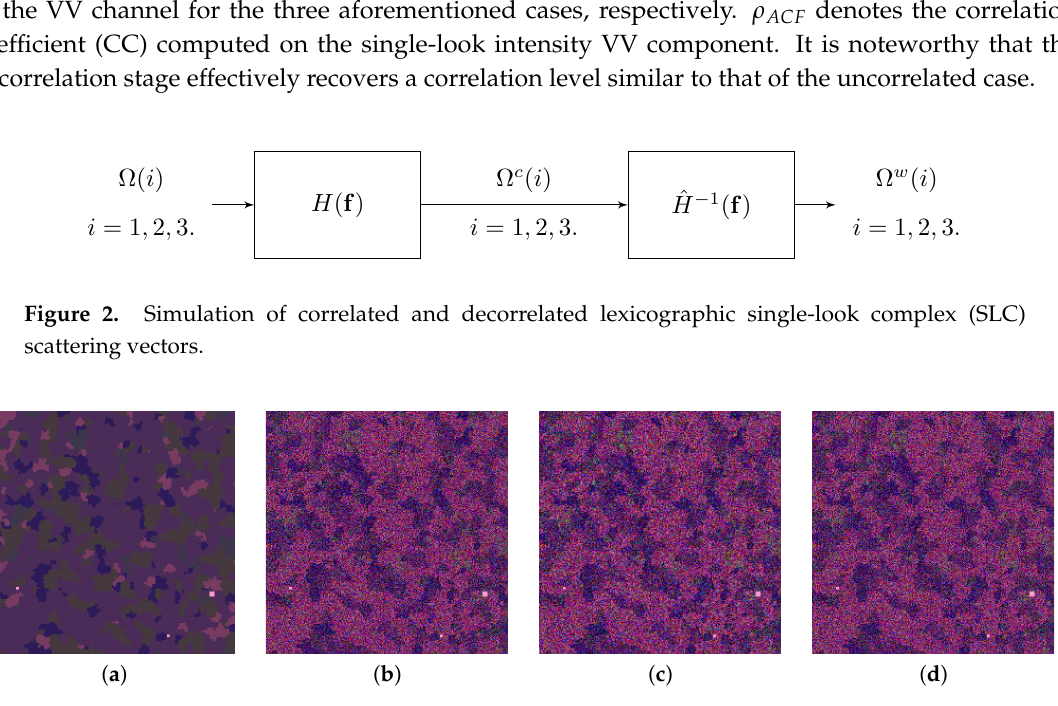
Figure 3. Example of a 256 256 simulated PolSAR image in Pauli RGB (red: × 2 , blue: 2 ). ( a ) Multilook complex (MLC) ground-truth (GT); ( b ) SLC S hv S hh + S vv green: √ 2 | | | | with uncorrelated speckle; ( c ) SLC with correlated speckle; ( d ) SLC with spatially-decorrelated correlated